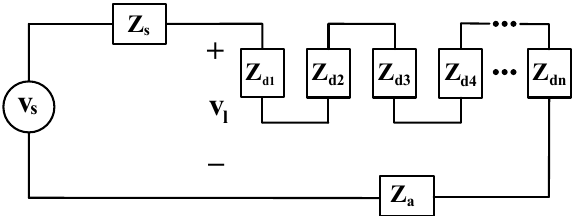
Figure 6. Effect of increasing distance from the PCC on load side impedance.